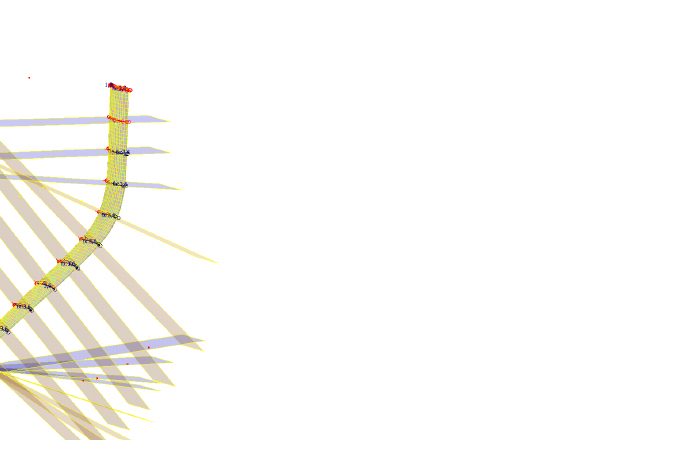
Figure 6. Planes used for extraction of normal span-wise cross sections along the foil to create the geometry for the numerical simulations.